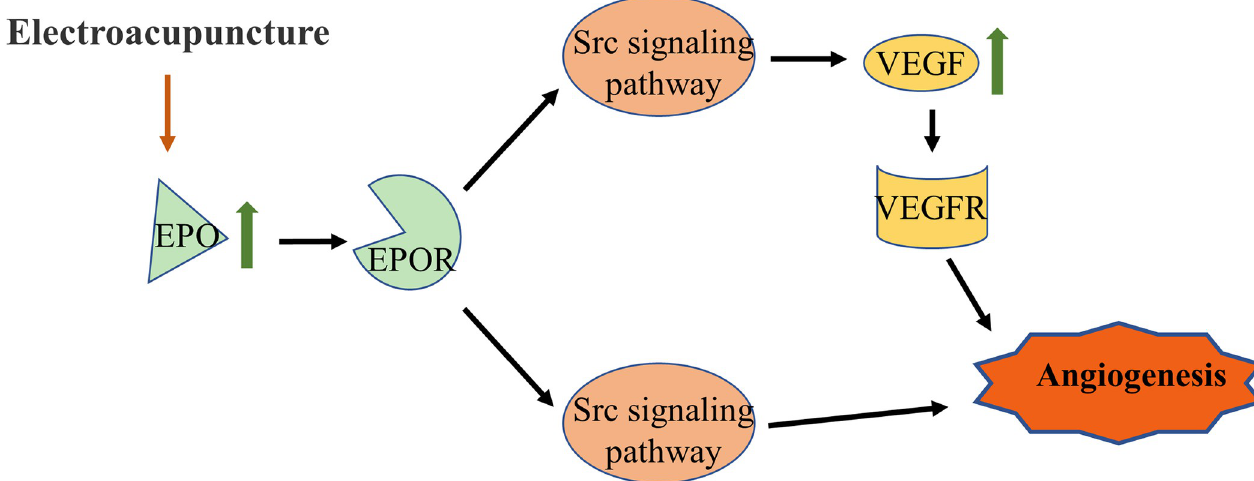
Fig 6. EA activated EPO mediated Src signaling pathway and VEGF signaling pathway to promote angiogenesis in CIRI rat brain tissue. EA at GV26 increased the expression of EPO in the brain tissue of CIRI rats and promoted angiogenesis by activating the downstream Src signaling pathway. In addition, the increased EPO enhanced the pro-angiogenesis effect of EA at GV26 by promoting the expression of VEGF.